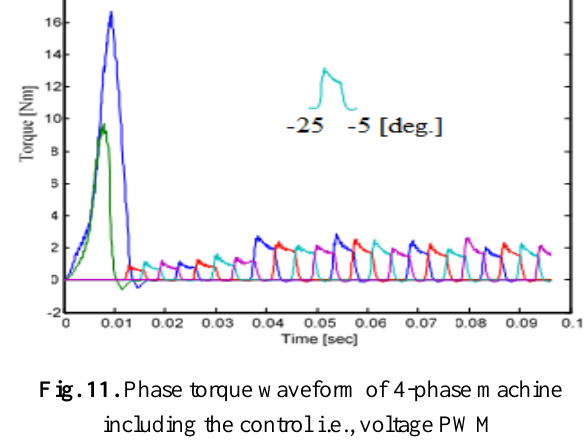
Fig. 8(b). Experimental waveform of phase current